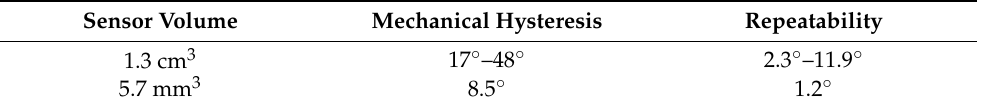
Table 1. Performance of the solid tilt